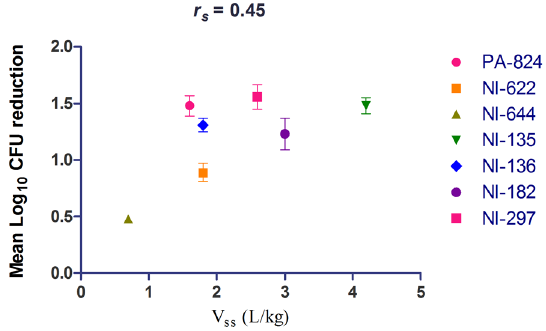
Figure 4. Correlation of volume of distribution with invivo efficacy in mice for bicyclic 4-nitroimidazole analogs. Each data point represents D Mean log lung CFU reduction compared to untreated controls (mean value 6 SEM from 5 animals). r s is the Spearman’s rank correlations coefficient.